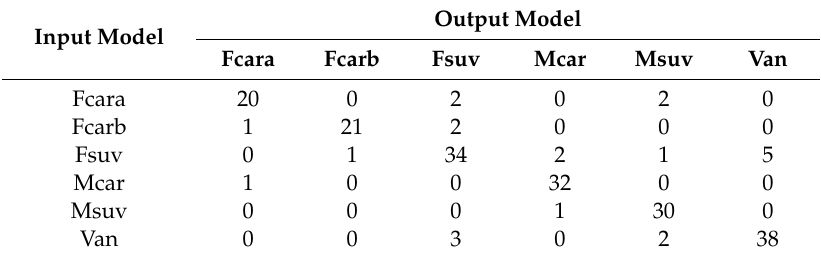
Table 1. The total confusion matrix for the recognition results of the test set in an experiment.